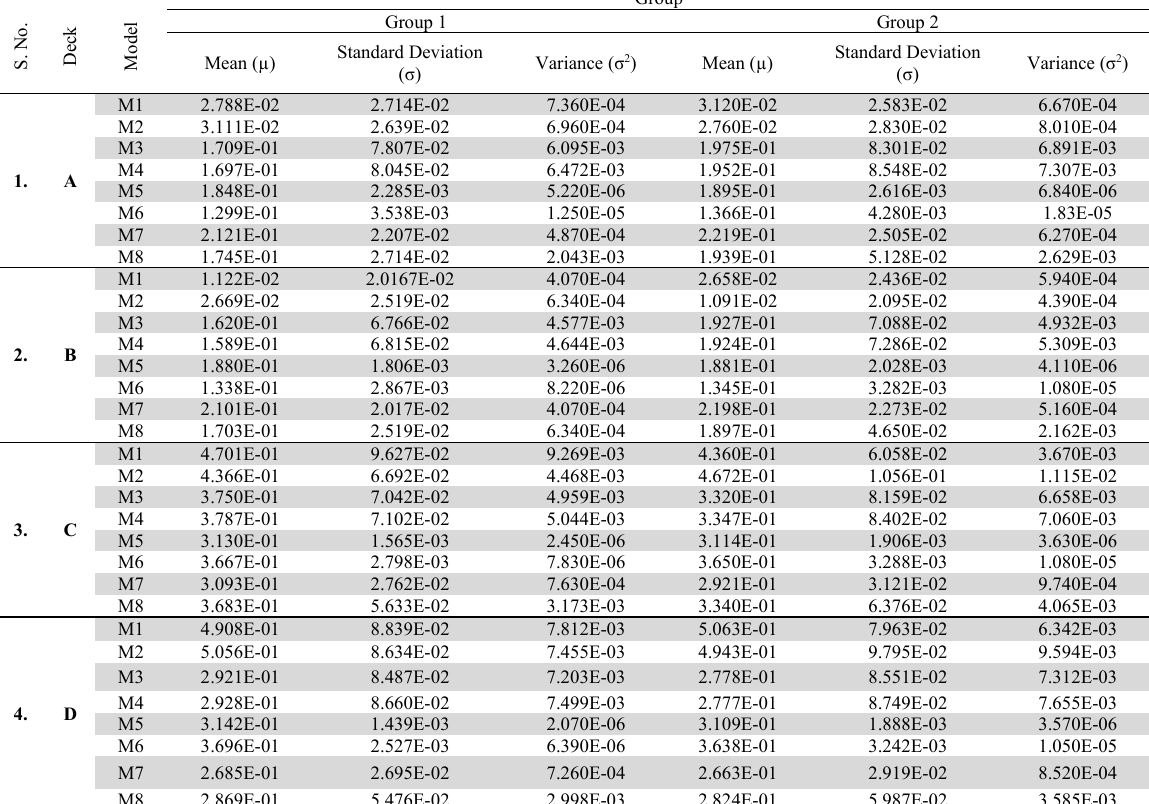
Table 3, represents the mean, standard deviation, and variance value of choice probability value for deck A, B, C and D. The values are computed for both groups separately for all decks. For G1, the mean probability of selecting Deck A and B is greater in model M7 (µ: 2.121E-01, σ : 2.207E-02 and σ 2 : 4.870E-04, for deck A; µ: 2.101E-01, σ : 2.017E-02 and σ 2